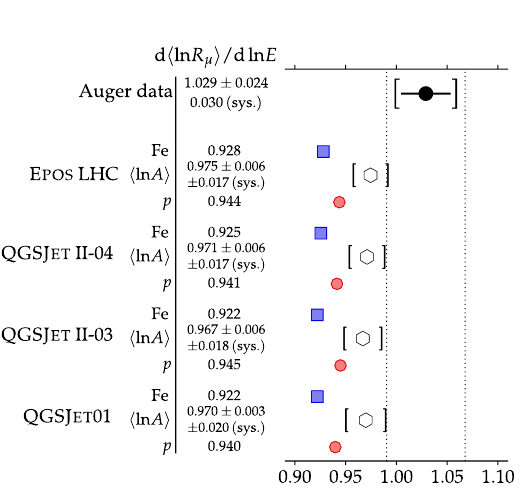
FIG. 7 (color online). Comparison of the logarithmic gain dhl R i dl E b t Figure 6. Comparison of the logarithmic gain between 4 × 10 18 eV and 5 × 10 19 eV with model predictions for proton and iron showers simulated at θ = 67 ◦ , and for such mixed showers with a mean logarithmic mass that matches the mean shower depth (cid:104) X (cid:105) measured by the FD. Brackets indicate systematic uncer- max tainties. Dotted lines show the interval obtained by adding sys- tematic and statisti- cal uncertainties in quadrature. The statisti- cal uncertainties for proton and iron showers are negligible and suppressed for